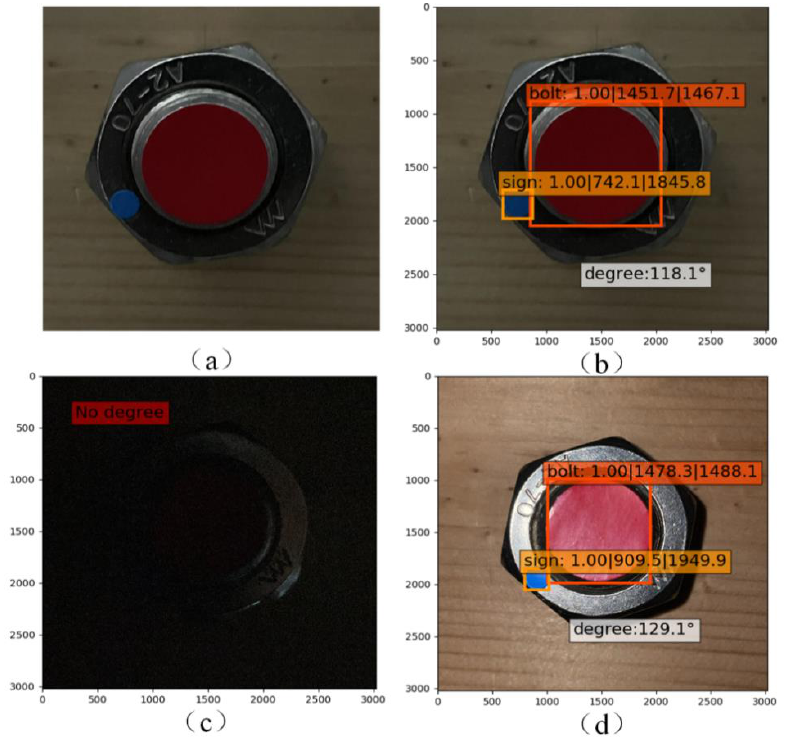
Figure 11. Verification results of lighting condition and shadow influence: ( a ) objects shot under weak lighting condition; ( b ) identification of the objects; ( c ) object shot under dark condition; ( d ) identification result of the object shot under camera flash.